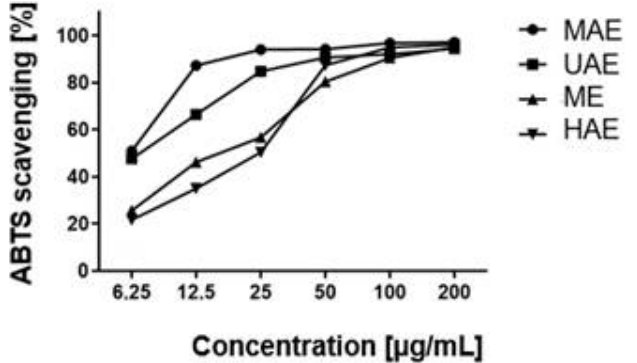
Figure 3. Antioxidant properties of Schisandra chinensis aqueous extract against ABTS solutions. UAE-ultrasound-assisted extraction; MAE–microwave-assisted extraction; ME–maceration with continuous stirring; HAE–heat-assisted extraction. The concentration range of extracts is from 6.25 to 200 µg/mL. Values are the mean of three replicate determinations ( n = 3).